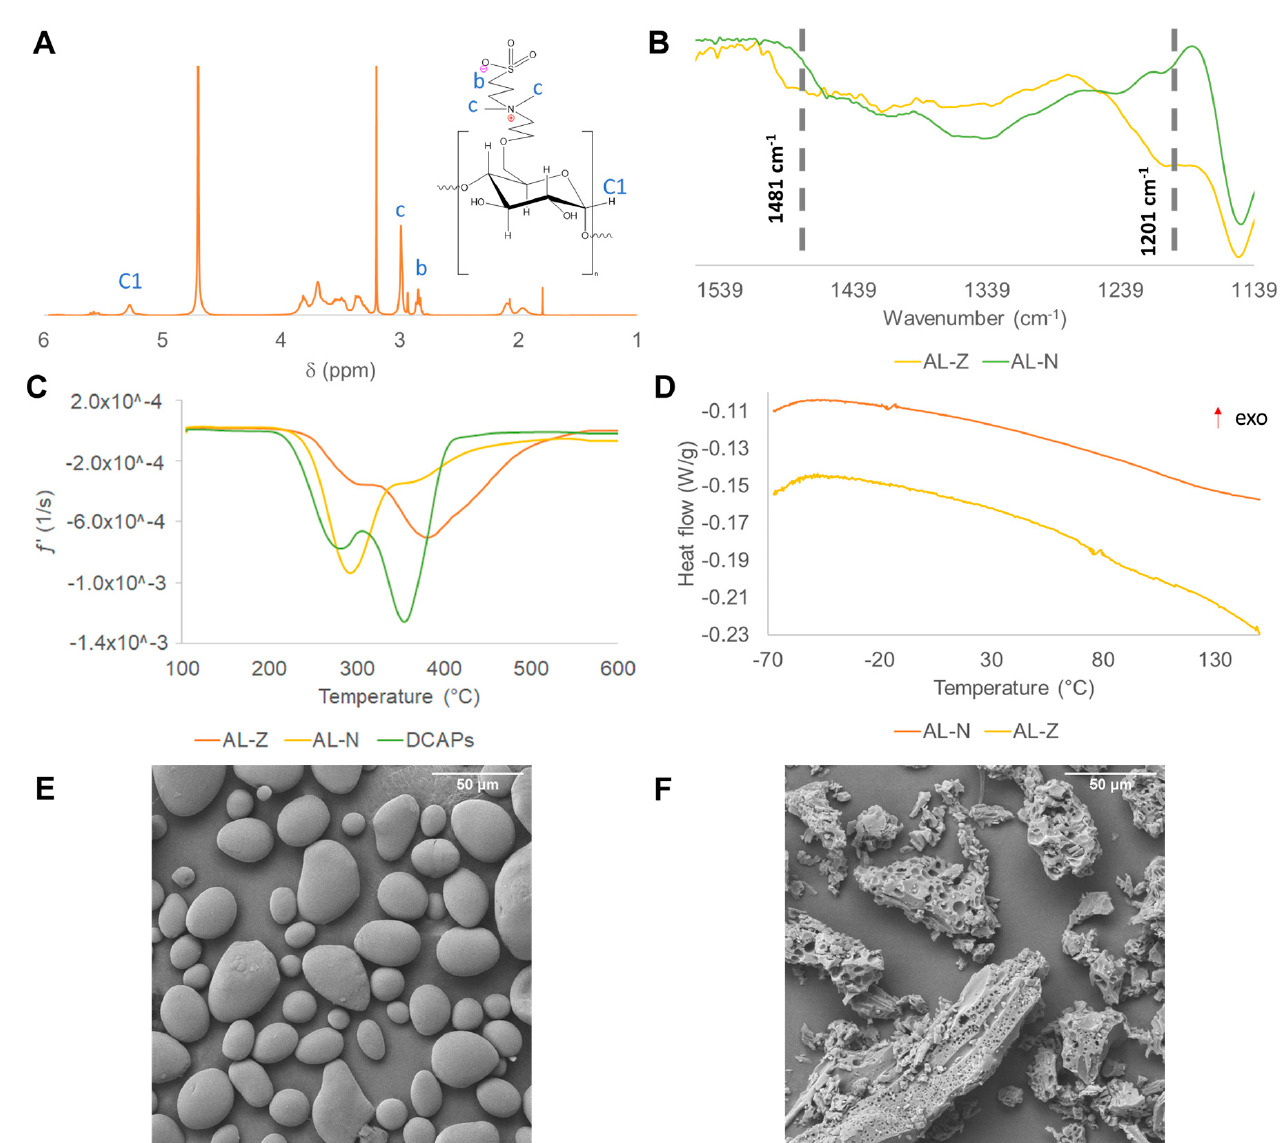
Figure 1. Characterization of starch (zwitterionic and native) by applying ( A ) 1 H RMH, ( B ) ATR-FTIR, ( C ) DTG, ( D ) DSC, and SEM to ( E ) potato starch and ( F ) zwitterionic starch.